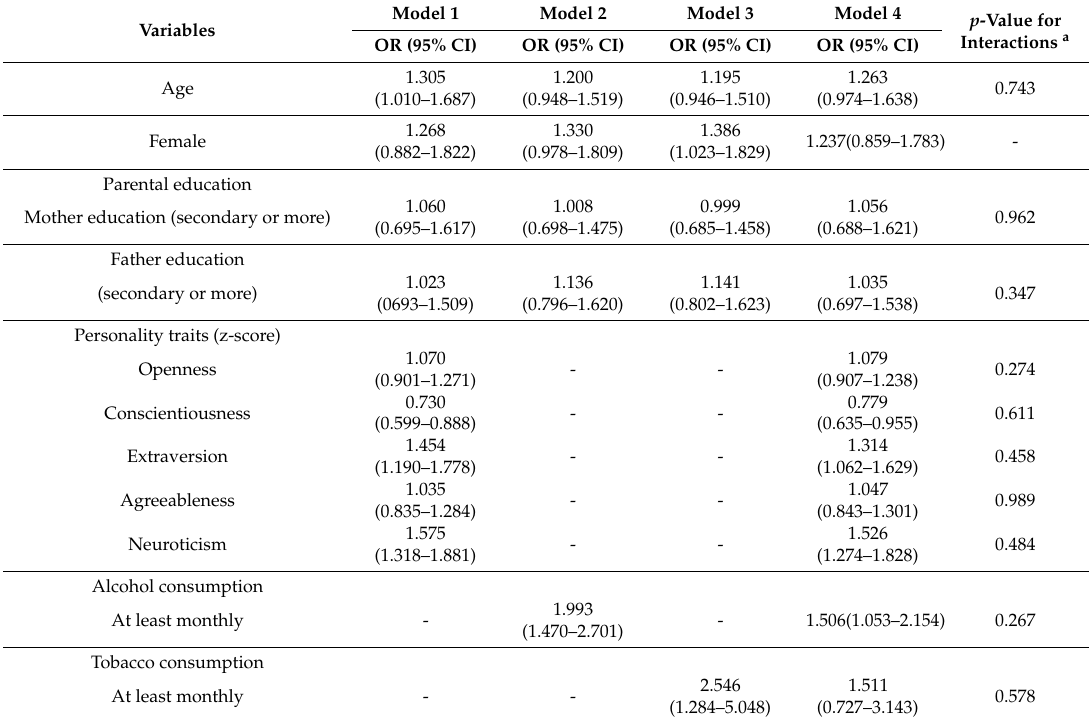
Table 2. Logistic regression models containing personality traits and drug consumption, predicting